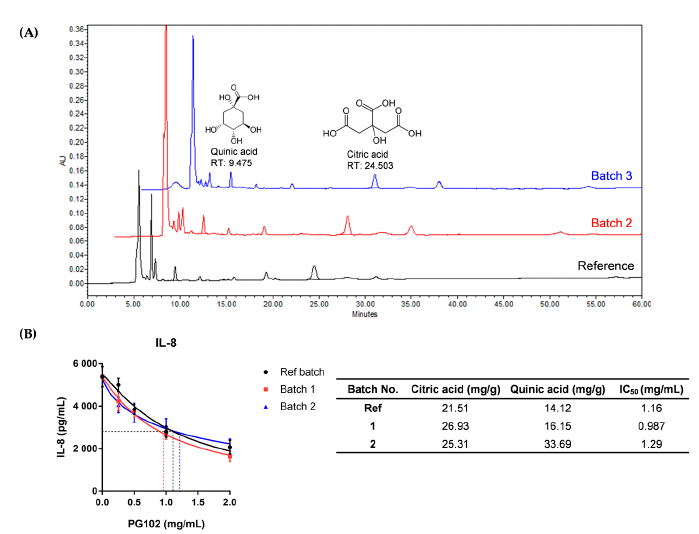
Figure 1. PG102 is a standardized extract from Actinidia arguta. ( A ) Quantification of marker compounds citric acid and quinic acid; ( B ) Interleukin (IL)-8 bioassay and half maximal inhibitory concentration (IC 50 ) of PG102 in HaCaT cells. Ref: reference. RT: retention time.